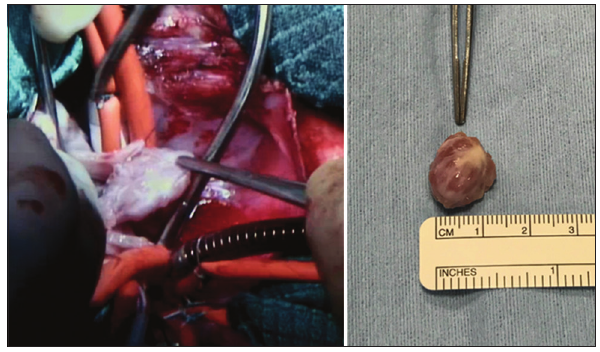
Figure 2: Intraoperative approach and view of the mass